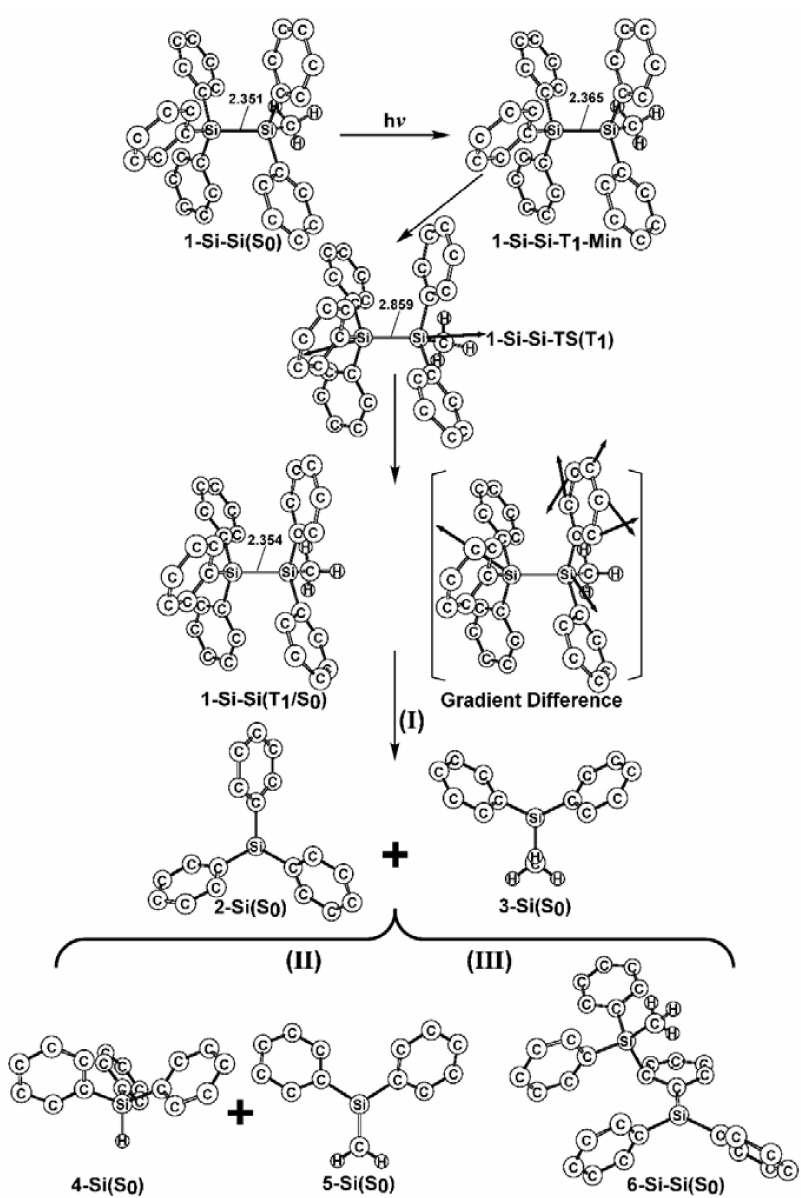
Figure 3. The optimized structures for the photochemical isomerization model of Ph 3 Si–SiPh 2 Me at the M06-2X/6-311G(d) level of